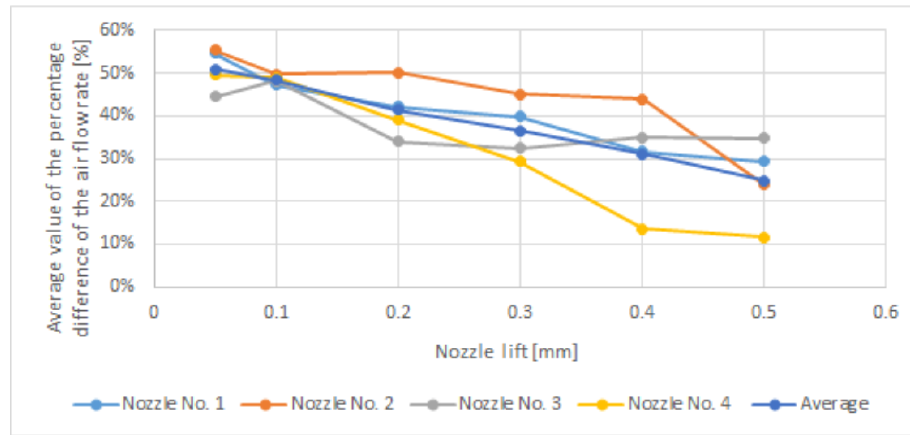
Figure 4. The mean value of the airflow rate for diesel fuel.